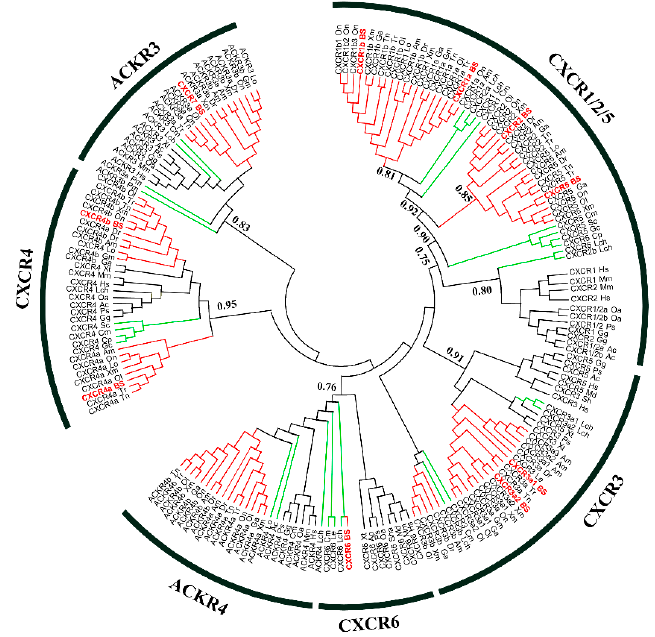
Figure 2. Phylogenetic analysis of vertebrate CXC chemokine receptors. Posterior probability values were included for the major nodes from supporting maximum likelihood analysis (values below 0.5 were not shown). The teleost fish are indicated in red; lower fish species including Leucoraja_erinacea (jawless fish), shark (cartilaginous fish), and Coelacanth ( Latimeria_chalumnae ), are shown in green; and non-fish vertebrates are shown in black.